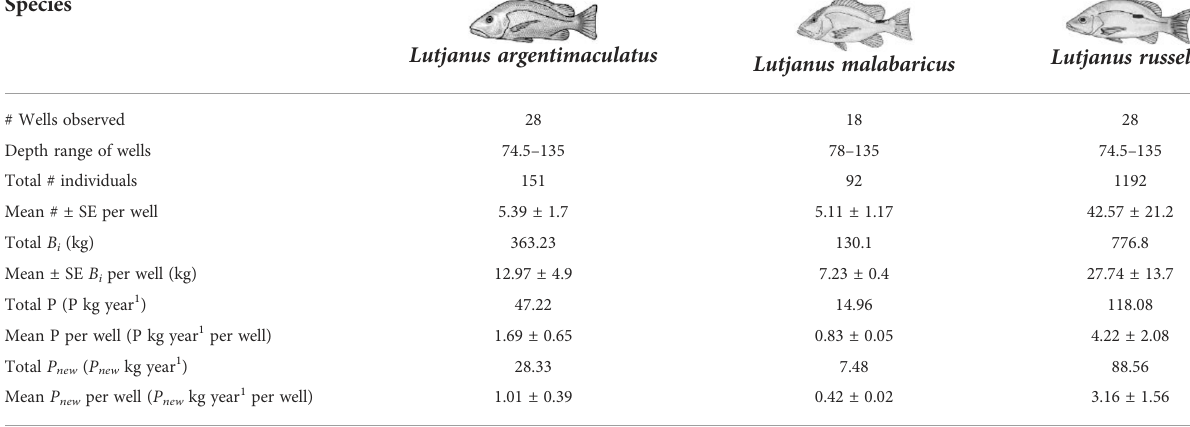
TABLE 5 Total and mean (±SE) abundance (from MaxN), biomass B i ), and production estimates for subsea wells on the northwest shelf, Western Australia.